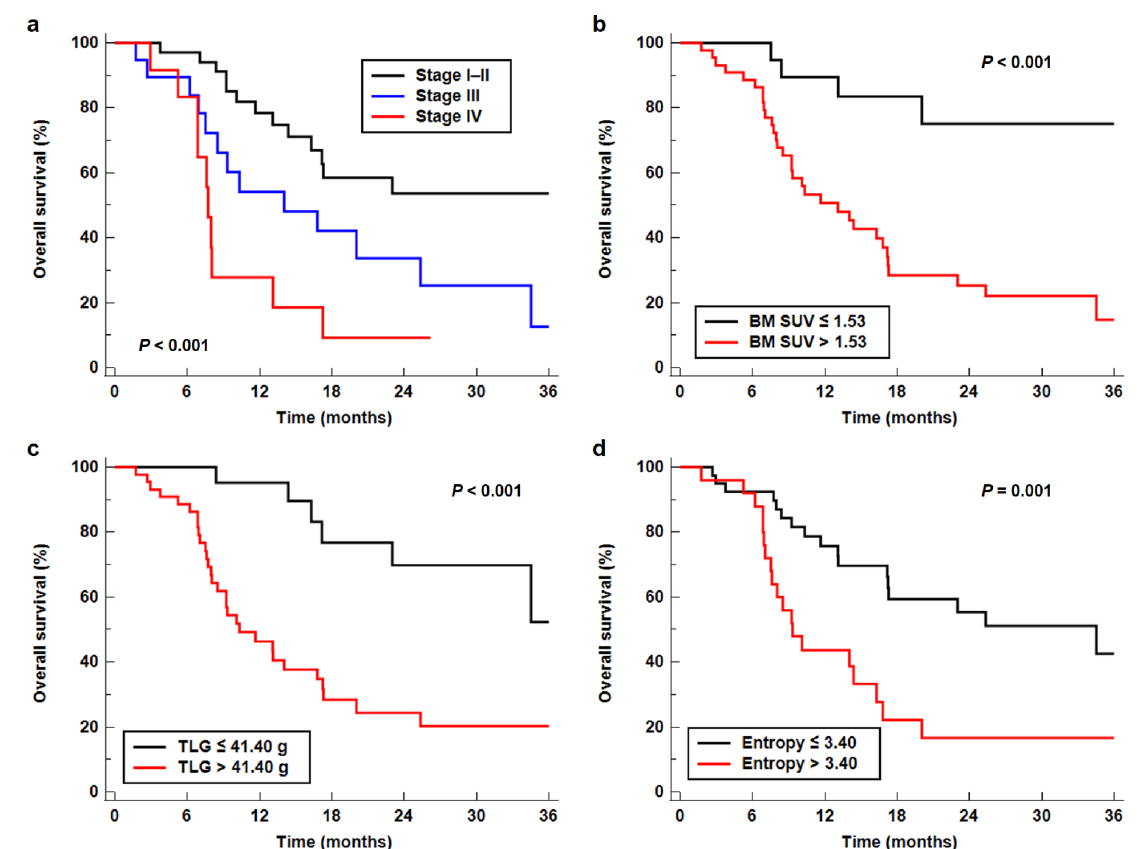
Figure 2. Kaplan–Meier curves for OS according to clinical TNM stage ( a ), BM SUV ( b ), TLG ( c ), and first-order entropy ( d ).